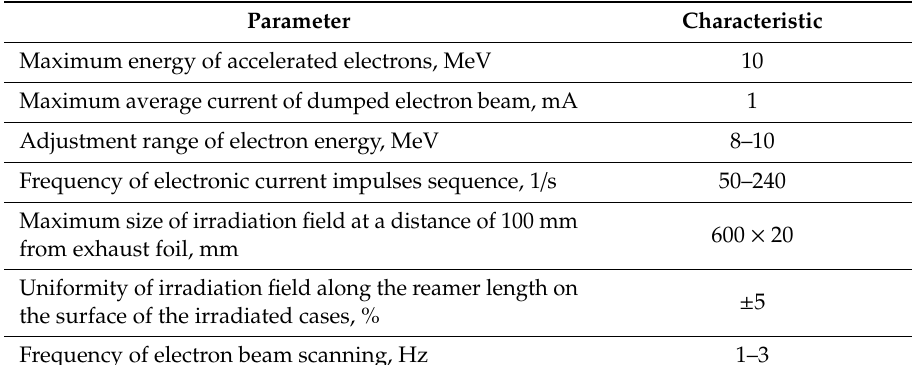
Table 1. Parameters of the beam of accelerated electrons of UELR-10-10C2 linear electron